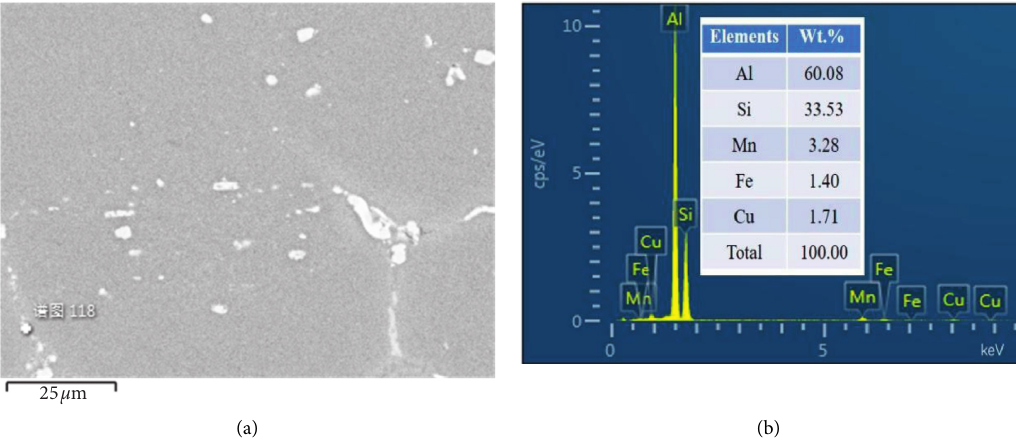
Figure 20: Typical SEM images of the brazed specimen rolled to 30% and annealed at 410 ° C.